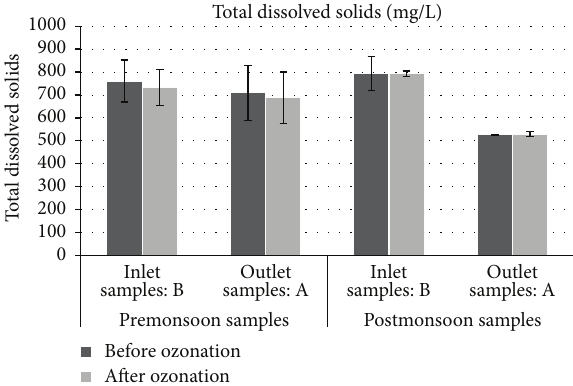
Figure 5: pH of inlet and outlet samples before and after treatment by ozone.